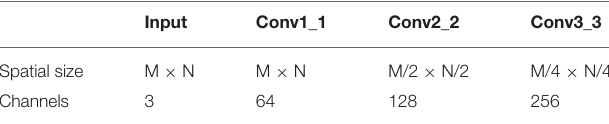
Frontiers in Neurorobotics |